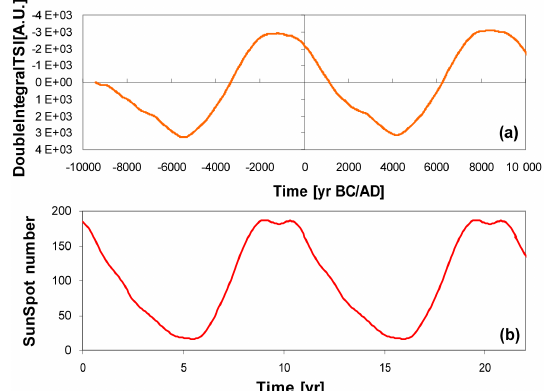
Figure B8. Comparison of (a) the double integral of the recon- structed solar activity (TSI) (Vertical scale of values were inverted because the double integral procedure changes the sign of the en- hanced result), and (b) the mean solar cycle obtained with an FS model based on SSN data from the World Data Center SILSO, Royal Observatory of Belgium, Brussels, over the period from 1964 to 2008.